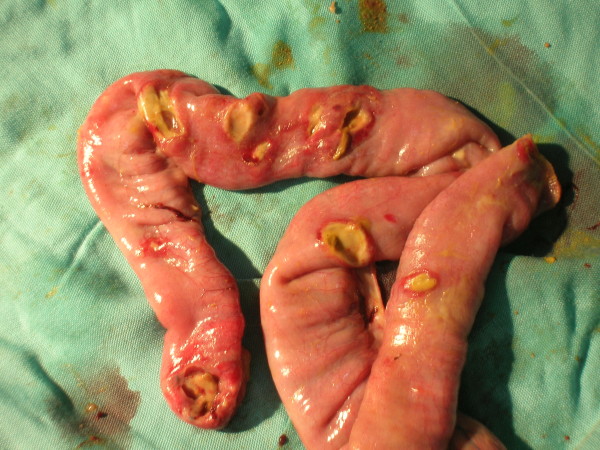
Multiple typhoid ileal perforations.